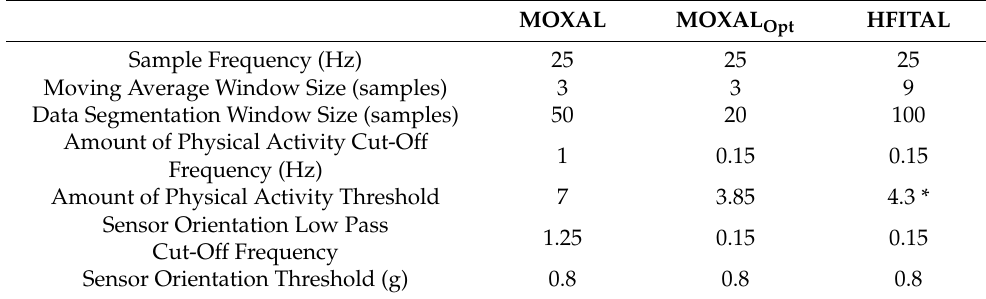
Table A1. Overview of the parameter settings of the activity classification algorithms evaluated during the optimization